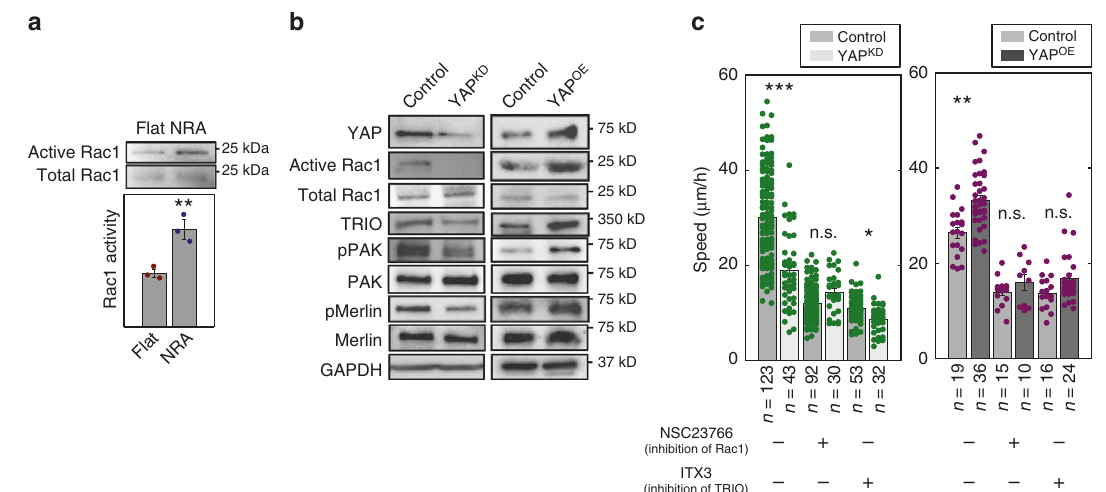
Fig. 5 Cell migration-enhancing effect of YAP via Rac1. a Rac1 activity assay using cells cultured on fl at surfaces and NRA ( n = 3 biologically independent samples, * = statistical signi fi cance of the ratio of active Rac1 to Rac1 on fl at surfaces vs. NRA. * P < 0.05). b Control, YAP KD , and YAP OE cells were immunoblotted to evaluate Rac1 activity via pull-down assay, expression of TRIO, and phosphorylation of PAK and Merlin. c Cell migration speed of individual cells in YAP KD (left) and YAP OE (right) cells in the marginal region of epithelial cell sheets on NRA in the presence of Rac1 inhibitor, NSC23766 and a TRIO inhibitor, ITX3 (each number of independently analyzed cells, n, is indicated, * = statistical signi fi cance of control vs. YAP KD and control vs. YAP OE cells with drugs, n.s = no signi fi cance, * P < 0.05, ** P < 1 × 10 − 2 , and *** P < 5 × 10 − 3 ). All error bars are S.E.M and statistical signi fi cance was determined by two-sided Student ’ s